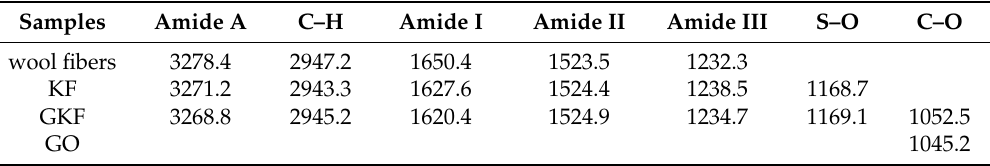
Table 2. Characteristic peak distribution of the test samples (cm − 1